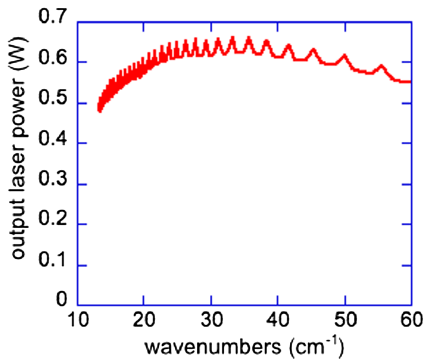
29. Required gain coefficient g extraction slit, and (2) with a transmission mirror (without slit).